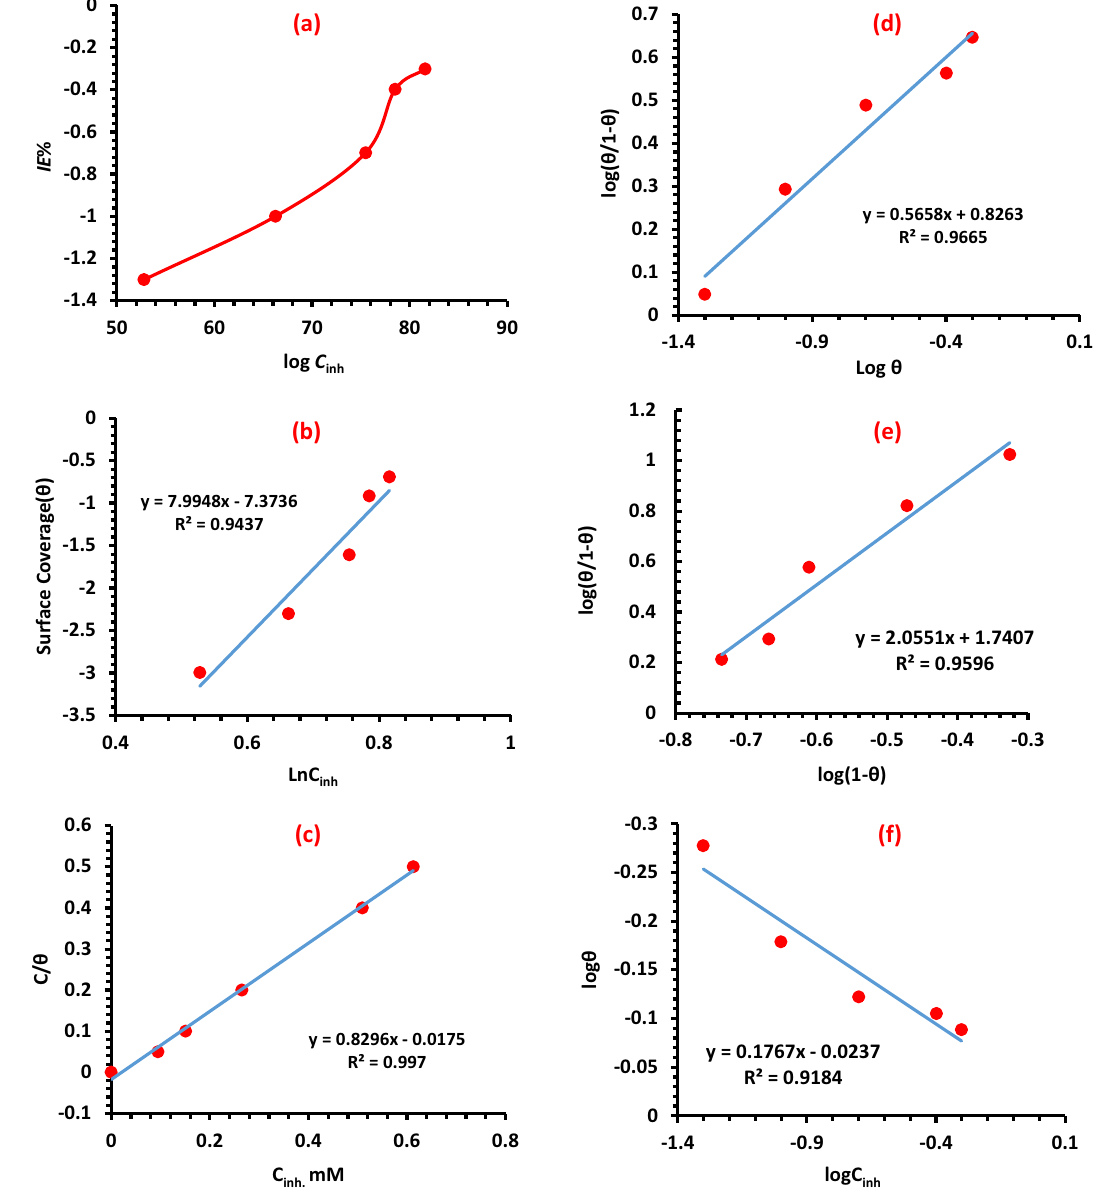
Figure 9. ( a ) Corrosion of carbon steel in 0.5 M H 2 SO 4 solution and the relationship between the IE % and APPH concentration, ( b ) Temkin adsorption isotherm, ( c ) Langmuir adsorption isotherm plot, ( d ) Kinetic- thermodynamic model, ( e ) Flory–Huggins adsorption isotherm, and ( f ) Freundlich adsorption isotherm.